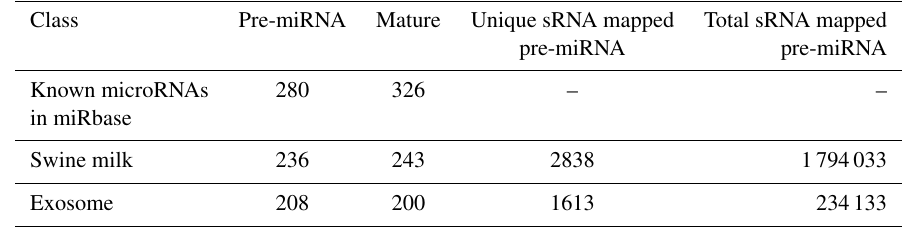
Table 1. Statistical analysis of microRNAs. Class